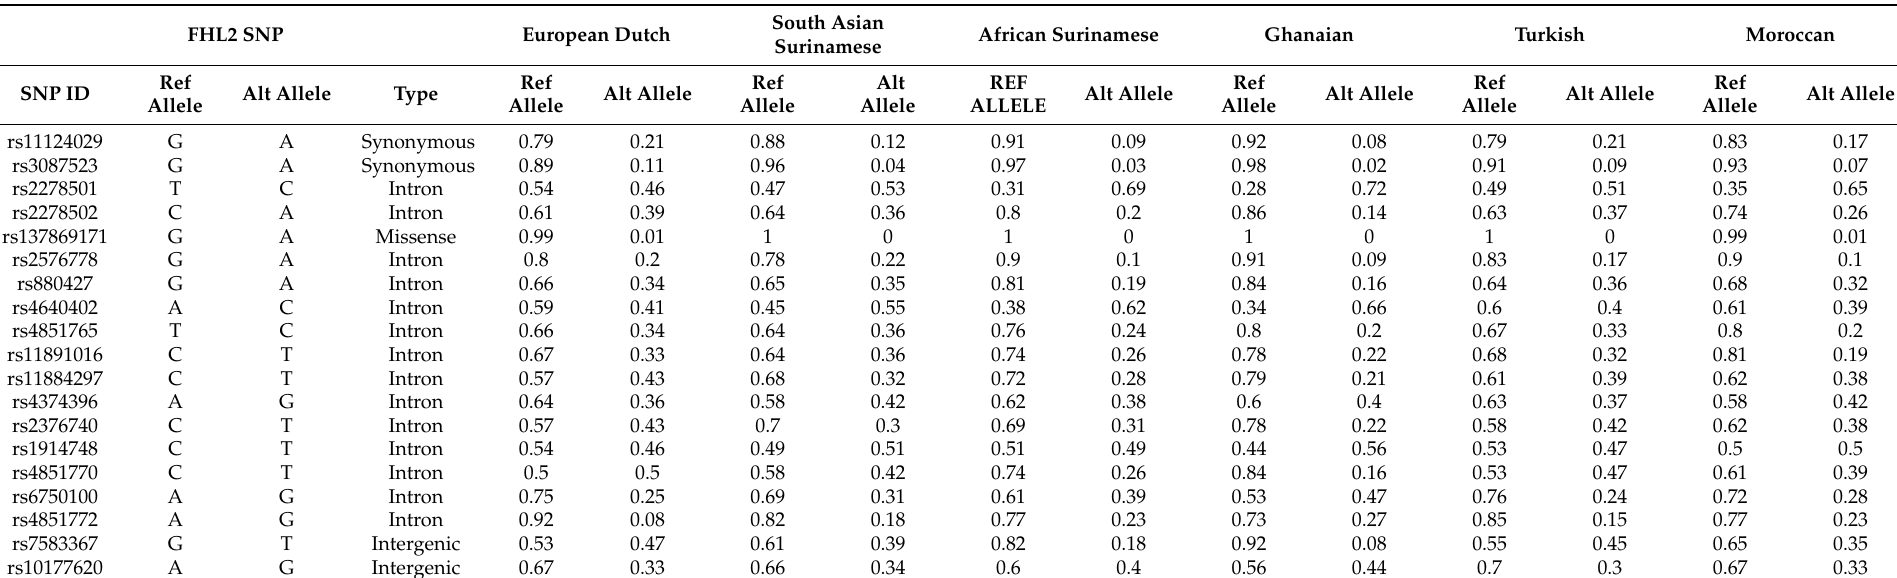
Table 2. Distribution of FHL2 SNPs per